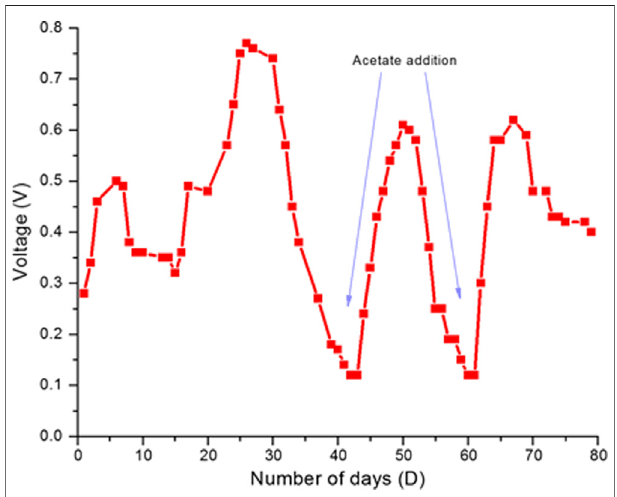
FIGURE 4 | Open circuit potential of MFC during bio fi lm